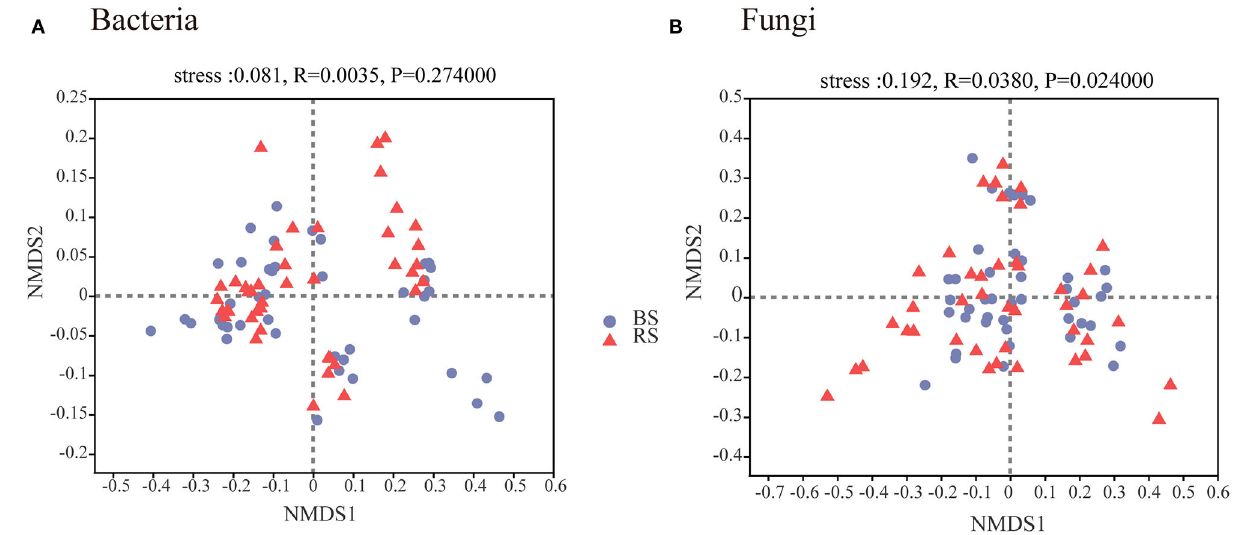
FIGURE 2 | Bacterial (A) and fungal (B) β -diversity characteristics in the rhizosphere and bulk soils. NMDS of Bray–Curtis distances at OTU level. BS and RS, bulk soil and rhizosphere soil, respectively.